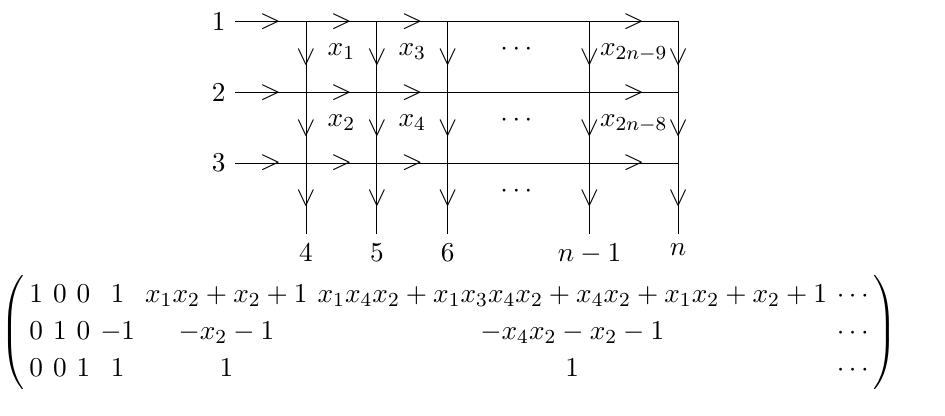
Figure 1 . A parameterization of G + ( k; n ) =T